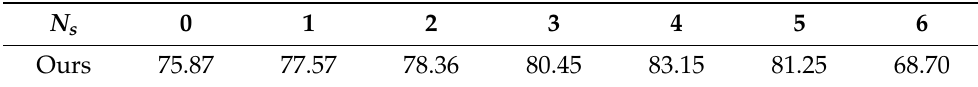
Table 5. Recognition accuracy (%) of the aerial scene classification using different selected numbers of samples N s for each category.